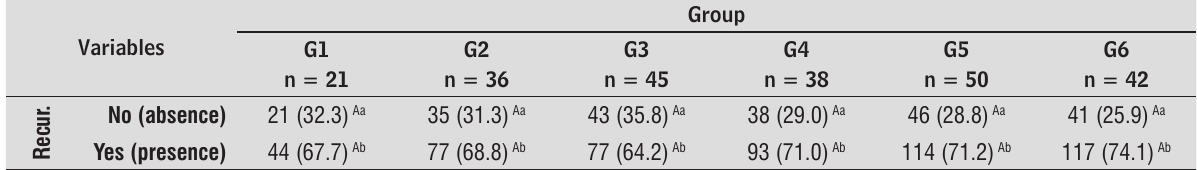
Table 2 - Absolute and relative ( % ) distribution of sports injuries, according to nature, anatomical site, etiological mechanism, and soccer player